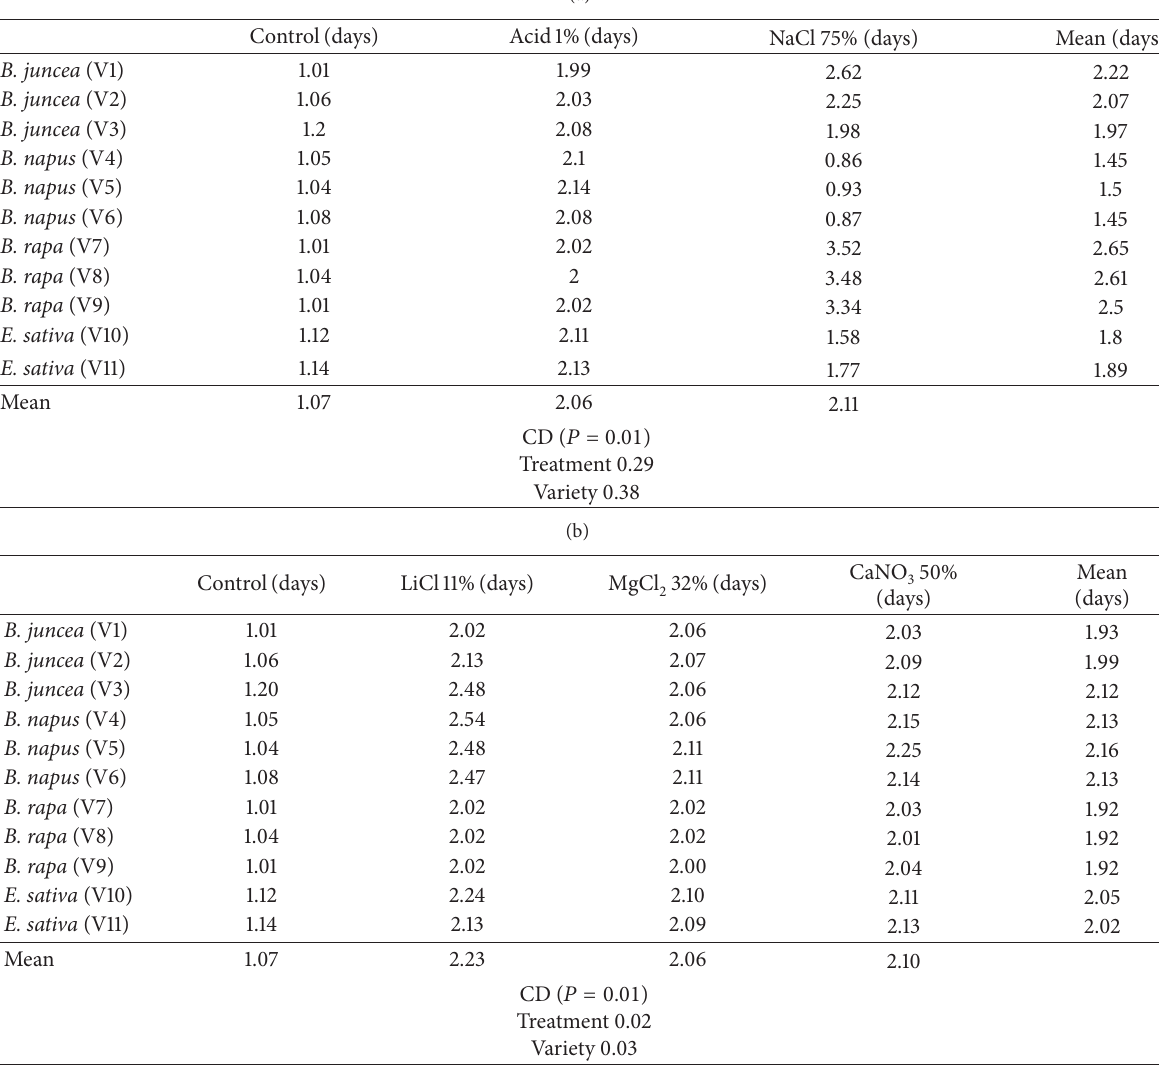
Table 2: Effect of high and low (a) and intermediate (b) RH on mean germination time of various accessions of Brassica spp. and Erucasativa